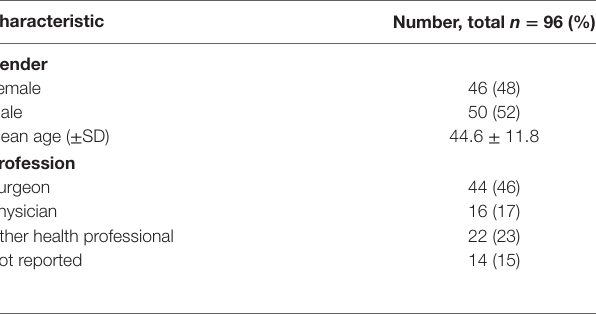
TaBle 1 | Demographics of course